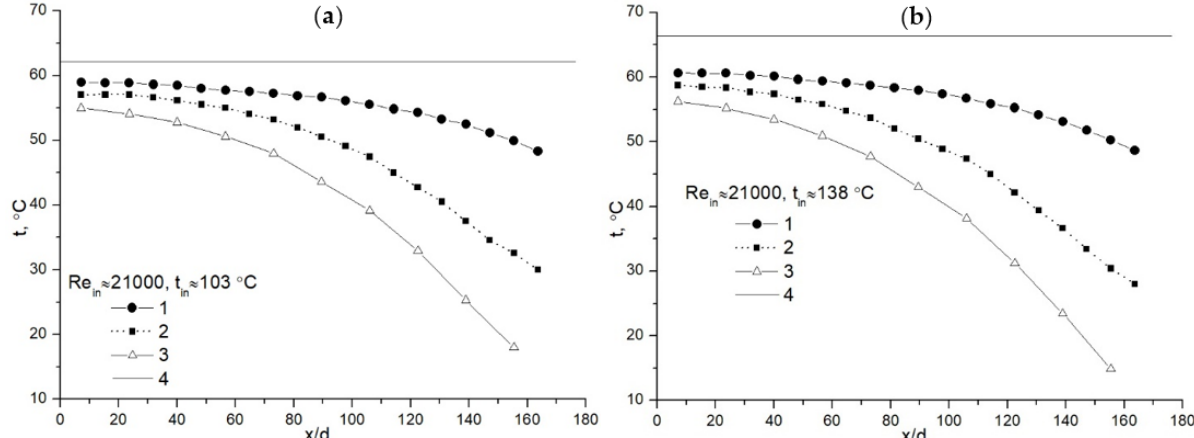
Figure 8. Temperature distribution along the model of the condensing heat exchanger at Re in ≈ 21,000, different flue gas inlet temperatures ( a ) t in ≈ 103 °C, ( b ) t in ≈ 138 °C and water injection of 40 °C: (1) center of the calorimetric tube, (2) the inner wall of the calorimetric tube, (3) cooling water in the middle of the inner and the outer tubes, (4) dew point temperature at the inlet to the calorimetric tube.